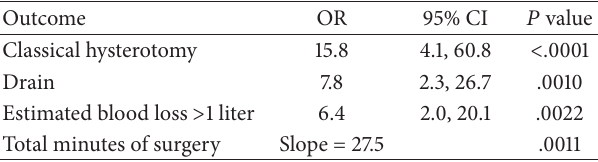
Table 3: Multivariate regression